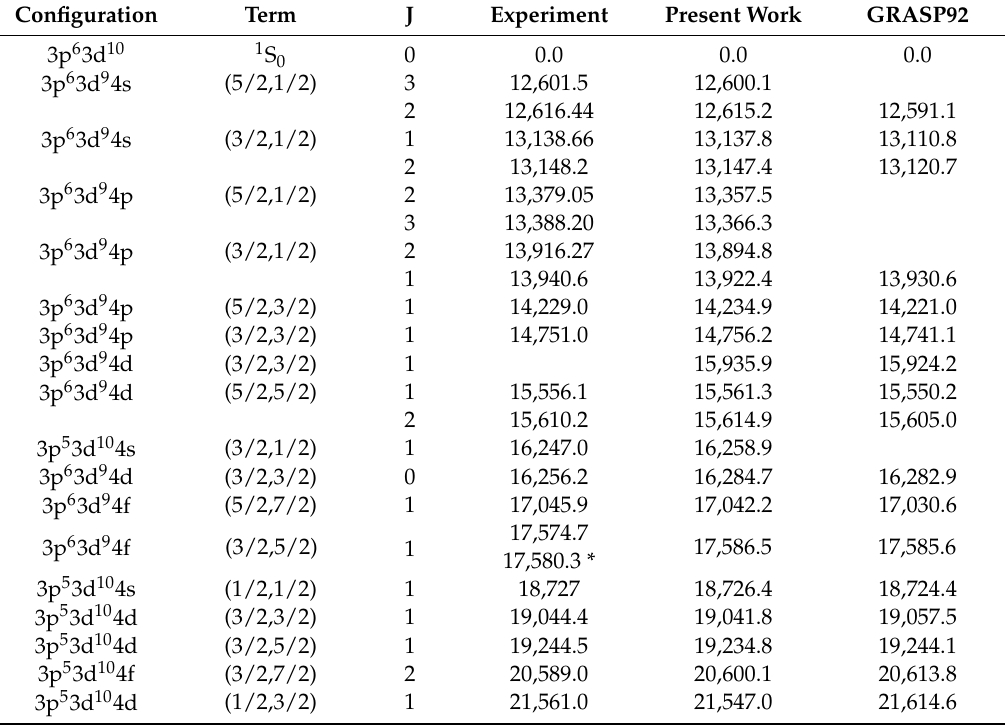
Table 1. Energy levels (10 3 cm − 1 ) of W XLVII. Comparison of present calculations with experimental data [22,23] and with calculations by GRASP92